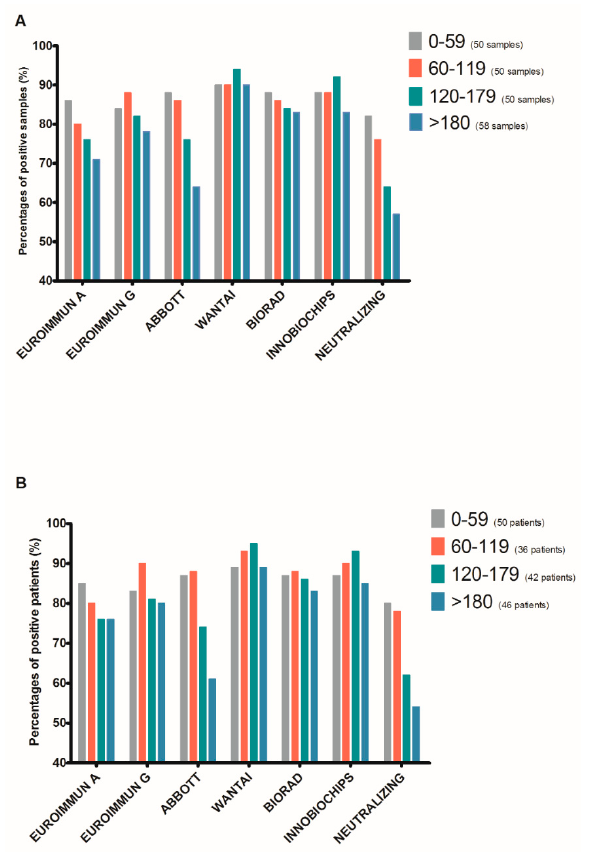
Figure 1. Percentage of SARS-CoV-2 seropositive specimens ( A ) or patients ( B ) obtained with various serological assays.